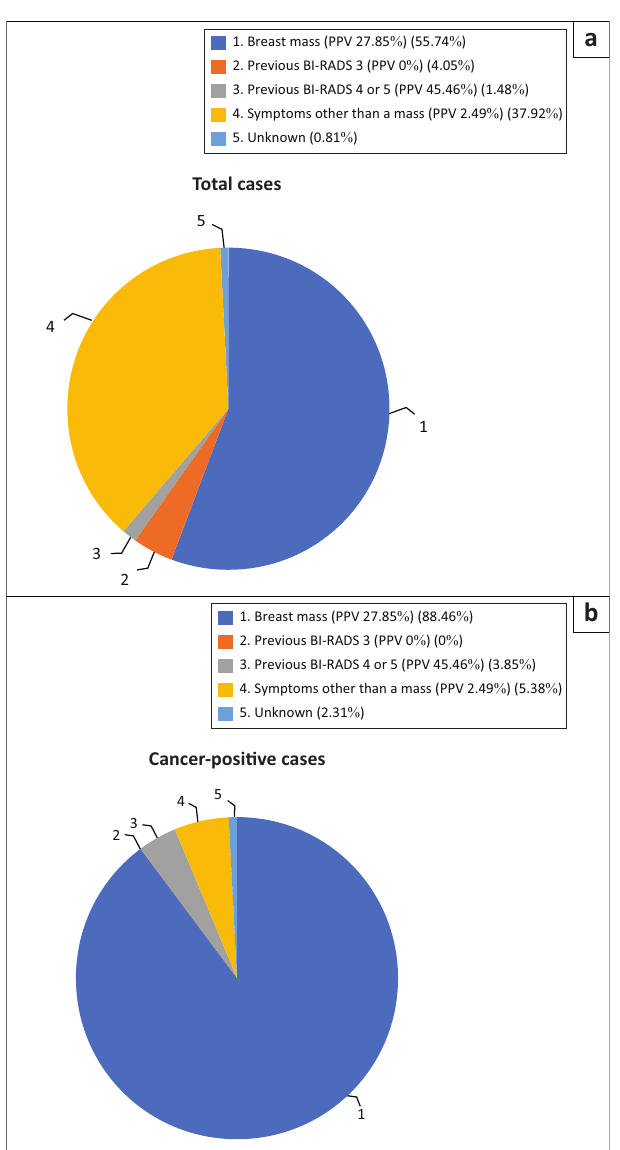
FIGURE 2 : Indications for diagnostic mammography: Total examinations and cancer-positive cases.